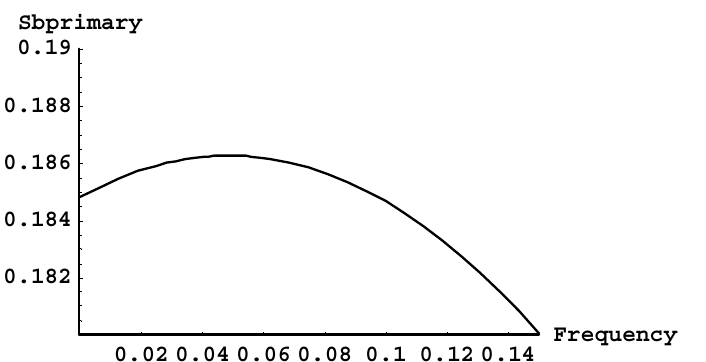
Figure 25. Magnified part of the primary blue component of the Ly-alpha line calculated at ε = 0 and q 2 = 1/10. The frequencies are in units of the Kepler frequency Ω of the outer electron (given by Equation (12.3)) [150].